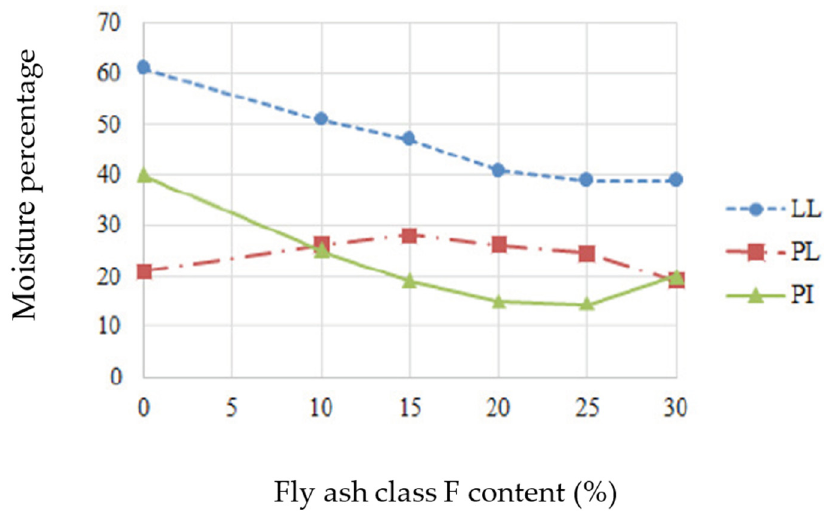
Figure 3. Fly ash class F impact on clay Atterberg limits.